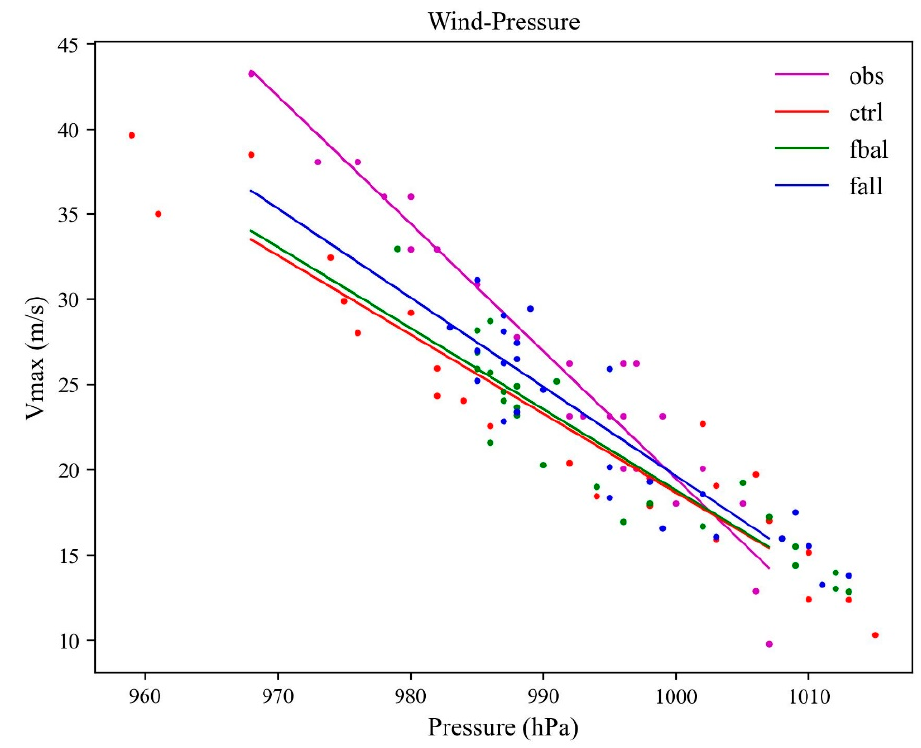
Figure 8. Relationship between maximum 10 m winds (Vmax) and minimum mean sea level pressure (MSLP); the initial forecast time is 0000 UTC on 20 October 2020.